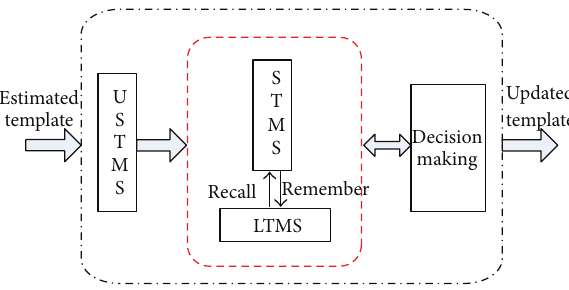
Figure 4: Three-stage memory model for appearance template